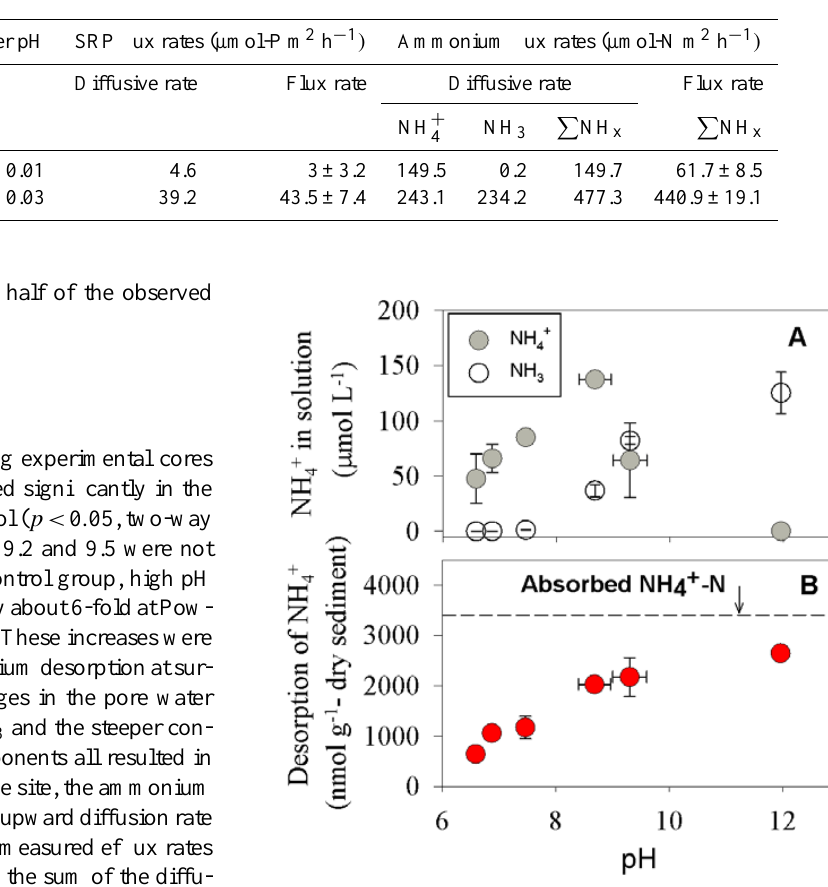
Fig. 3. Experimental pH effects on NH + concentration in solution 4 (A) and desorption of exchangeable NH + (B) , using the 0–2cm ho- 4 mogenized sediments from Budds Landing collected in November 2008. Dissolved NH + and NH 3 concentrations were estimated from 4 the P NH x concentrations and pH in the aquatic phase (Eq. 2). Des- orbed NH + was the sum of P NH x in water and the volatilized NH 3 4 in the headspace of the sealed centrifuge tubes (Eqs. (6), (7), and Ta- + and NH concentrations were estimated from the ∑ NH 4 3 ble 3). The dashed line represents “total” absorbed NH + , estimated 4 by KCl extraction of pH-neutral sediment (Eq. 5). The vertical and horizontal error bars are the standard errors of ammonium and the pHs, in the headspace of the sealed centrifuge tubes (Eq. 6, Eq. 7, and 7 3